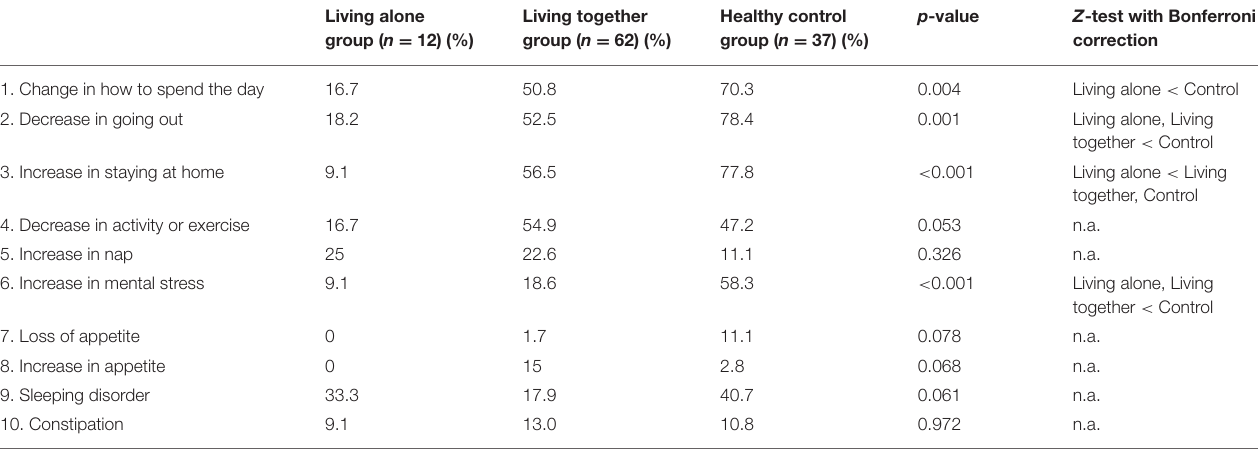
TABLE 3 | Positive response rate for each question in the three groups.